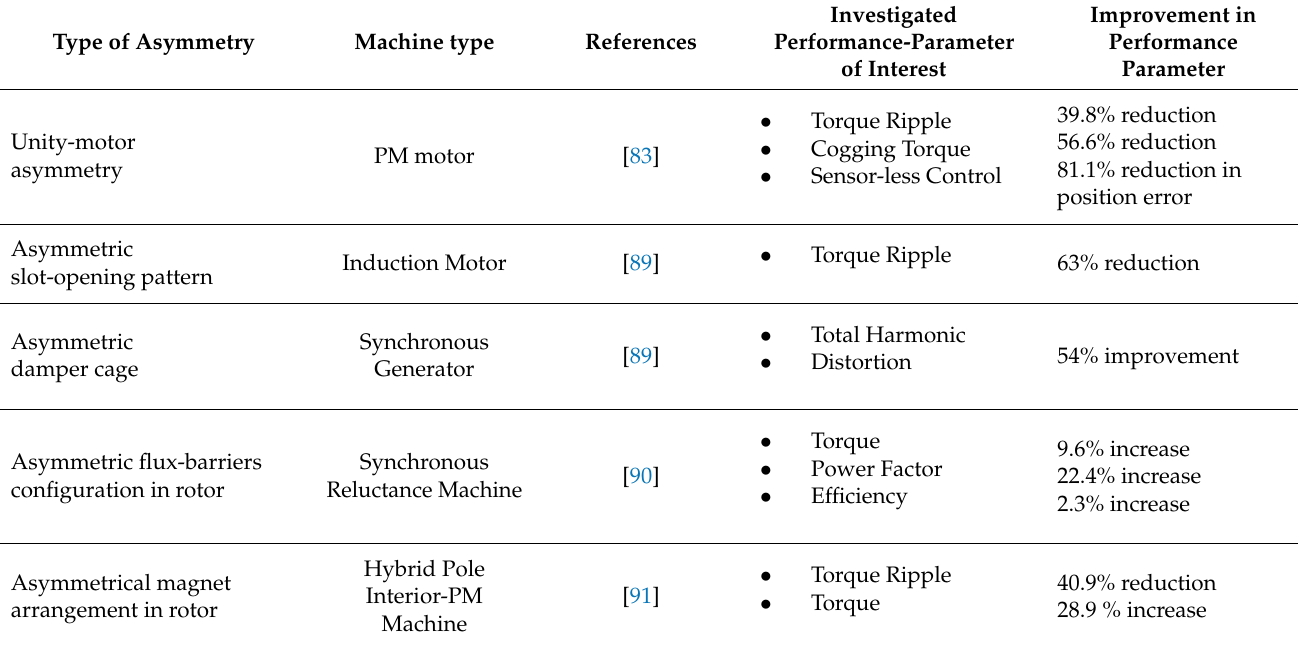
Figure 9. Concept of; ( a ) unity-motor asymmetry in rotor [83] ( b ) asymmetric slot-opening pattern (induction motor) [89] ( c ) asymmetric damper-cage topology (synchronous generator) [89] ( d ) hybrid- pole IPM machine with an asymmetrical magnet configuration in rotor [91]. Table 1. Introduction of asymmetry in machine design with corresponding